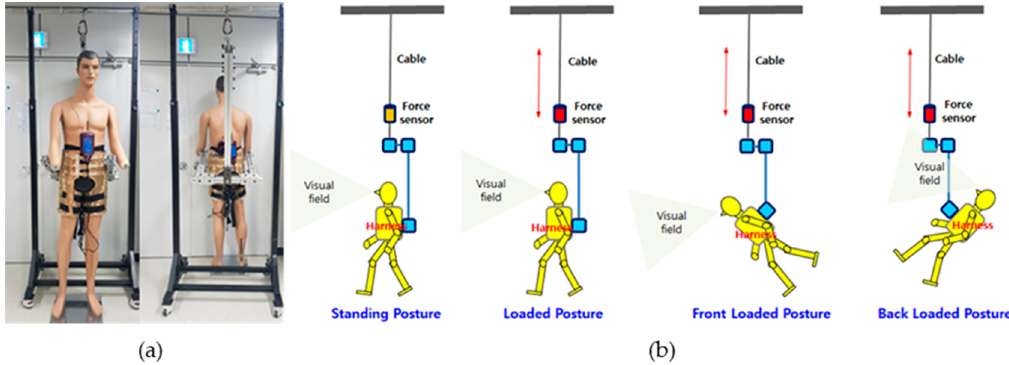
Figure 7. ( a ) Mannequin wearing the harness and ( b ) the four postures in the experiments.